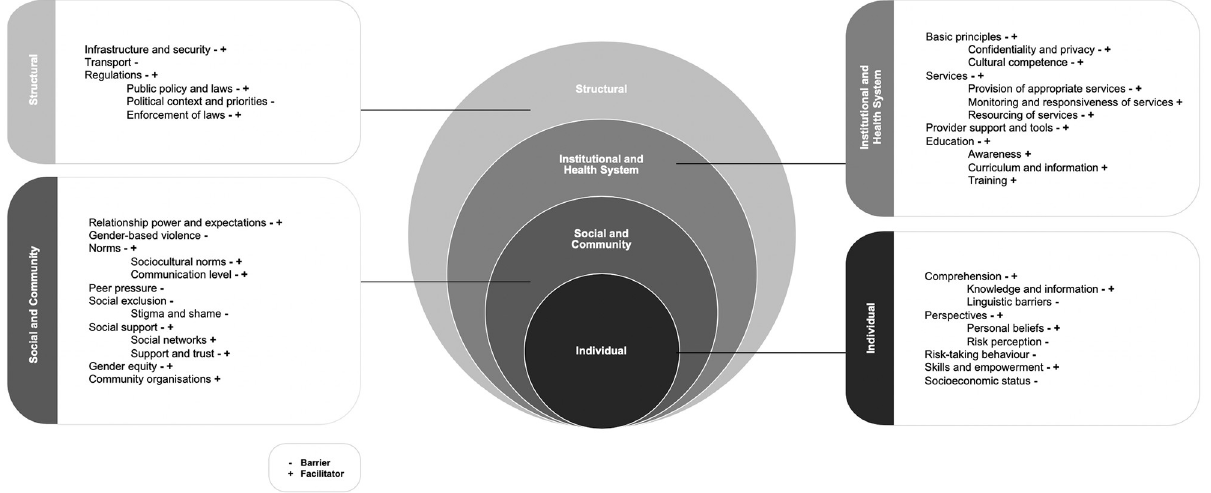
Fig 2. Socio-ecological framework showing barriers and facilitators for the SRHR of young refugees.